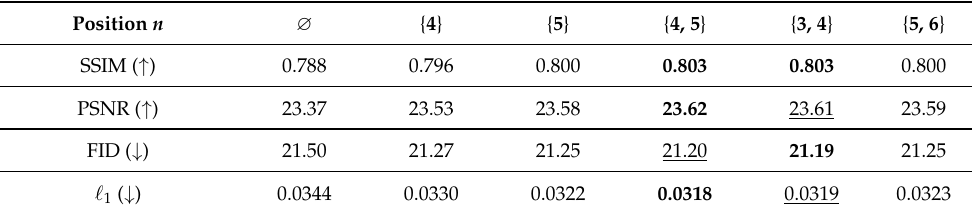
Table 2. Quantitative results for the ablation study on the MSCA module. Position